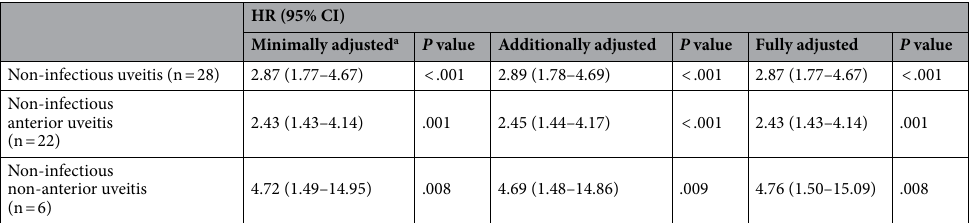
Table 5. The hazard ratio of uveitis in PCOS patients after propensity score matching. a Minimally adjusted: age; Additionally adjusted: age, region of residence, household income; Fully adjusted: age, region of residence, household income, comorbidities (autoimmune) b . b Comorbidities: Behcet’s disease, Juvenile idiopathic arthritis, Ankylosing spondylitis, Systemic lupus erythematosus, Ulcerative colitis, Tuberculosis, Sarcoidosis, Crohn’ disease, Multiple sclerosis, Reactive arthritis.